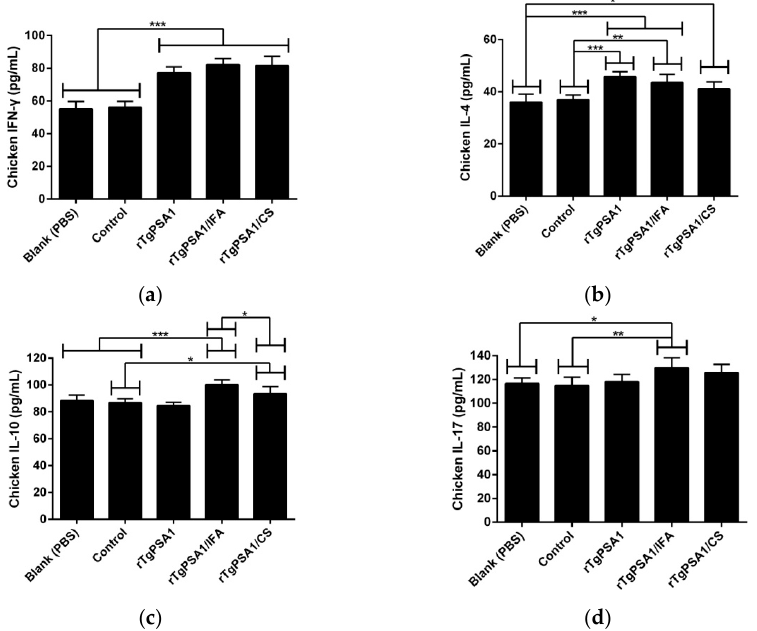
Figure 9. Cytokine secretions of chickens. Commercially available ELISA kits were used to determine levels of ( a ) IFN- γ , ( b ) IL-4, ( c ) IL-10, and ( d ) IL-17 in sera two weeks after second immunization (six weeks old). Each sample was con- ducted once. Results were evaluated using one-way ANOVA followed by Dunnett’s test, and values are shown as mean ± SD (n = 5). Values between rTgPSA1/IFA and rTgPSA1/CS groups were compared with the independent t -test. * p < 0.05, ** p < 0.01, and *** p < 0.001 compared with blank or control group.